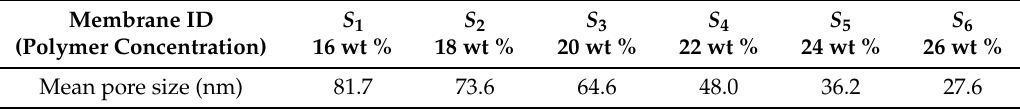
Figure 4. Effect of total polymer concentration on water flux for PVDF/PVA blend membranes S 1 – S 6 .